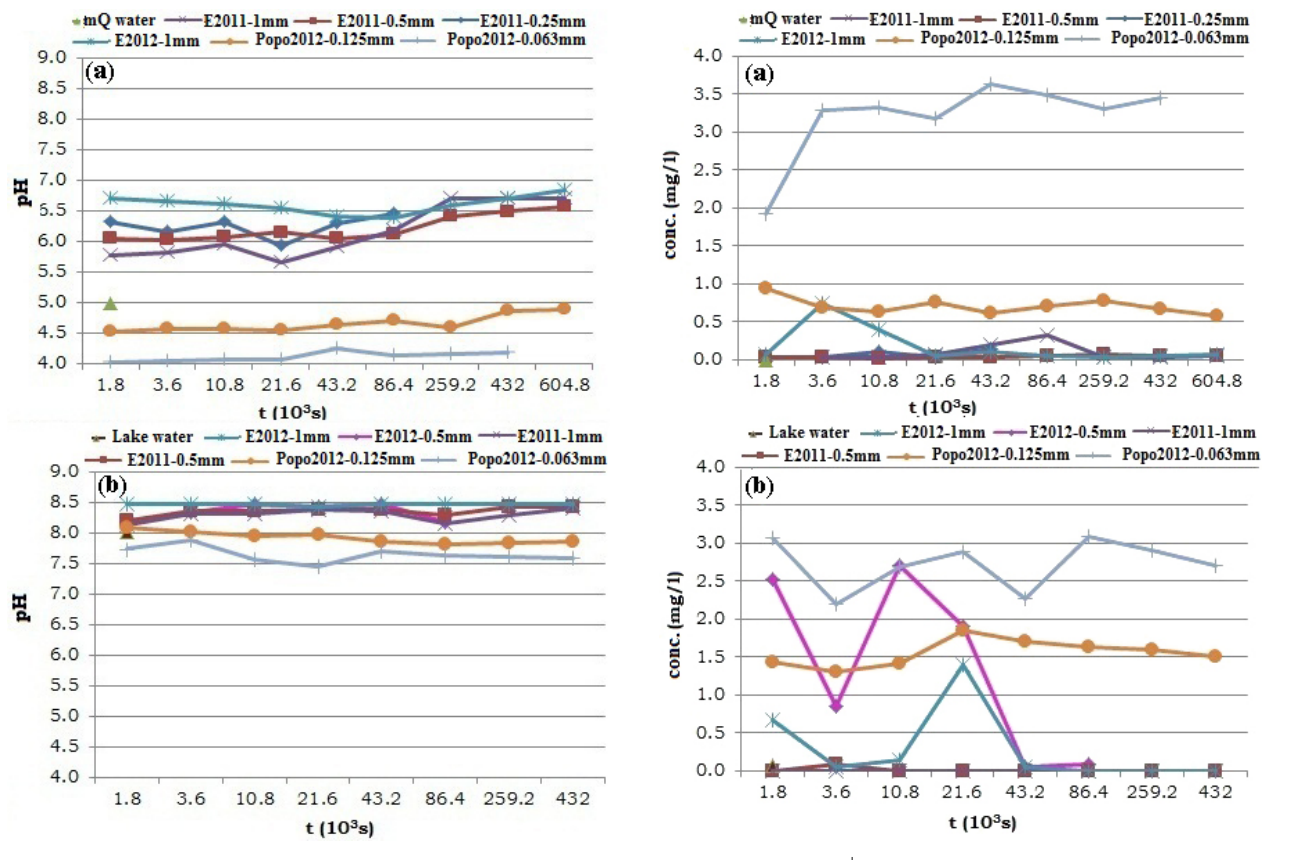
Figure 5. Panel (a) shows pH variation of ash leachates in mQ; and (b) pH variation of ash leachates in lake water. The samples were washed using variable stirring times and different grain size. The pH of mQ and lake water is indicated for comparison.